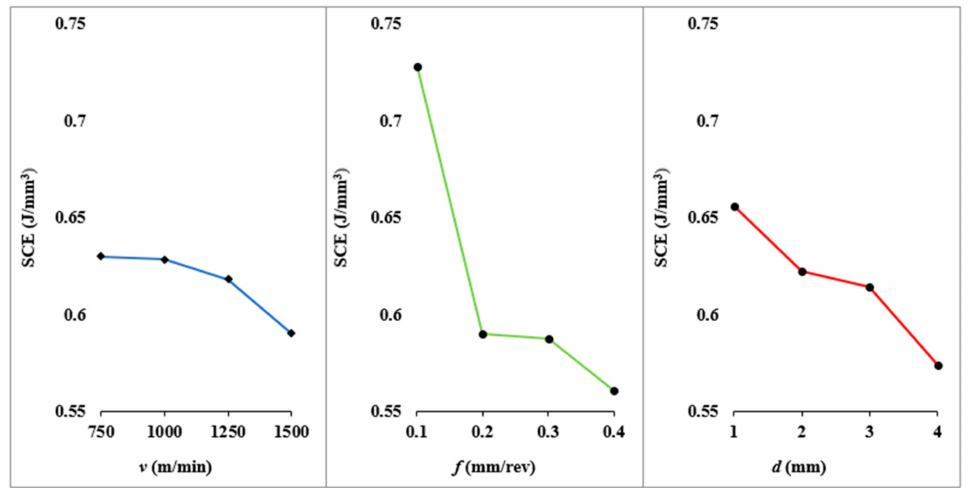
Figure 6. Main effect plots showing the influence of cutting parameters on SCE in TSM.